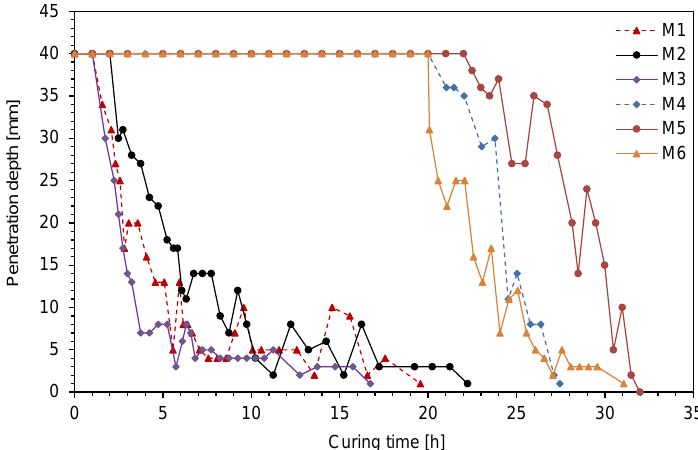
Table 5. Setting times of the CLSM mixtures.